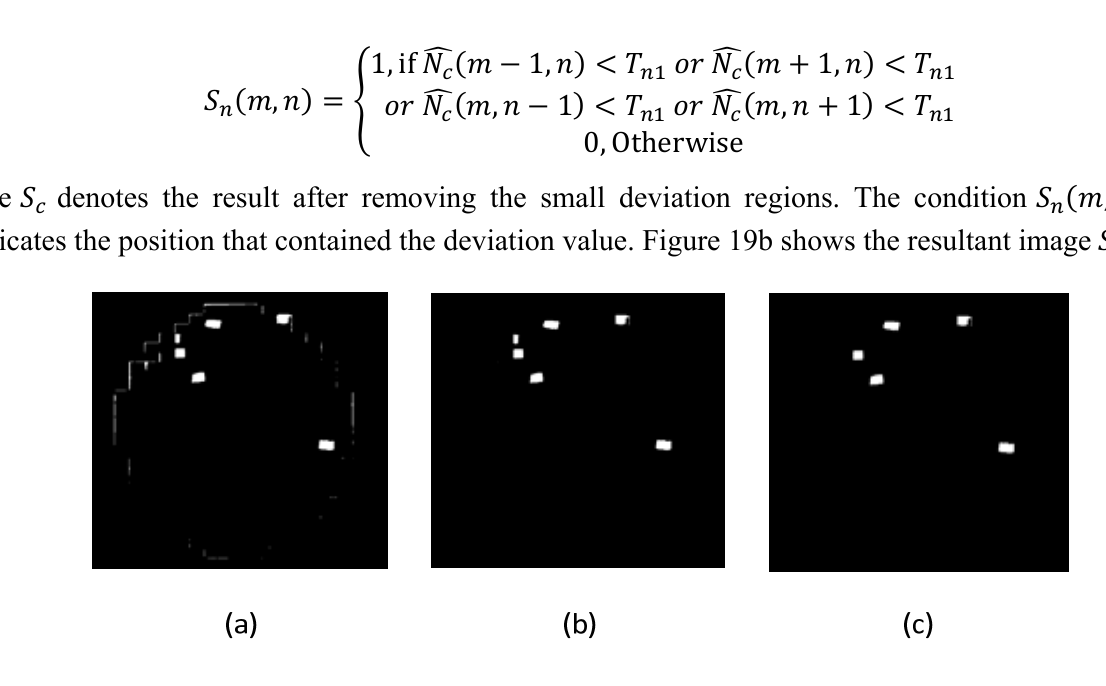
Figure 19. ( a ) The dies with small deviation regions in the abnormal case; ( b ) the result after removing the small deviation regions; ( c ) the final dies in the abnormal